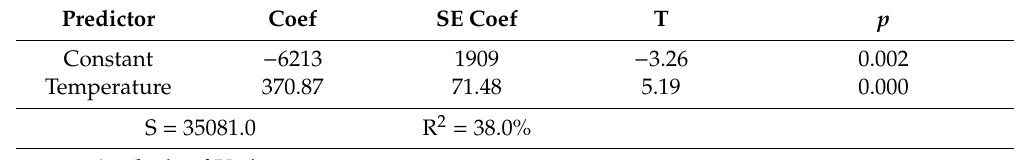
Figure 9. Comparison of monthly dengue cases versus rainfall with regression equation in Lahore, 2007–2012.